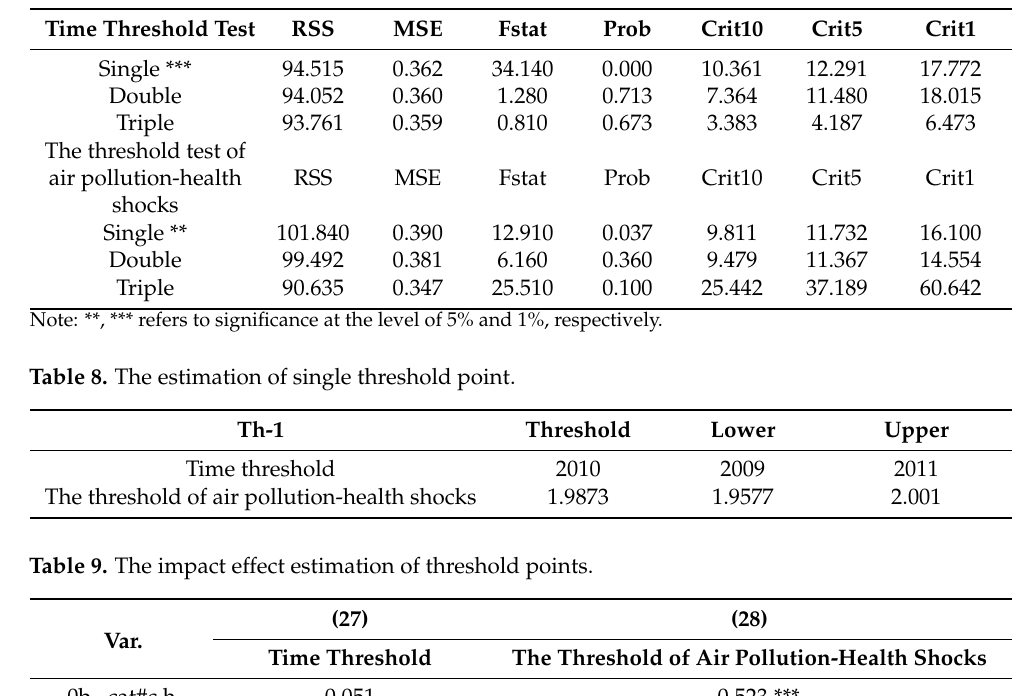
Table 7. Indicators of driving forces of urban resilience.